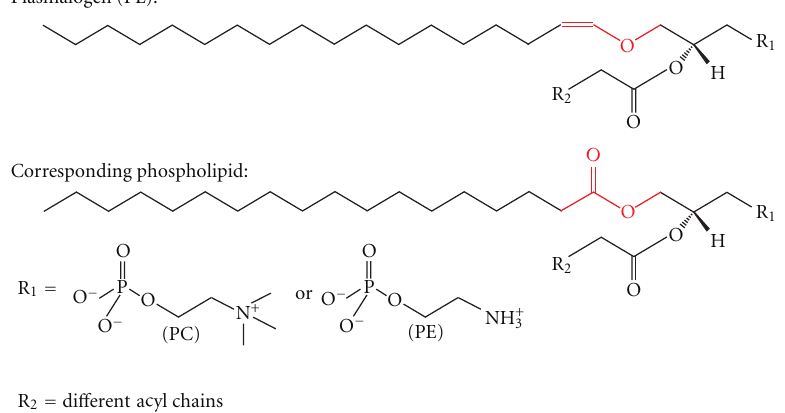
Figure 1: Structure of plasmalogen (PL) and the corresponding phospholipid used in this study. In the plasmalogens, the fatty acid is linked via an enol ether bond instead of an ester bond marked in red. Residue 1 (R1) can either be a phosphatidylcholine or a phos- phatidylethanolamine leading to PC-plasmalogen or PE-plasmalogen. The sn-2 position can vary in di ff erent fatty acids symbolized by residue 2